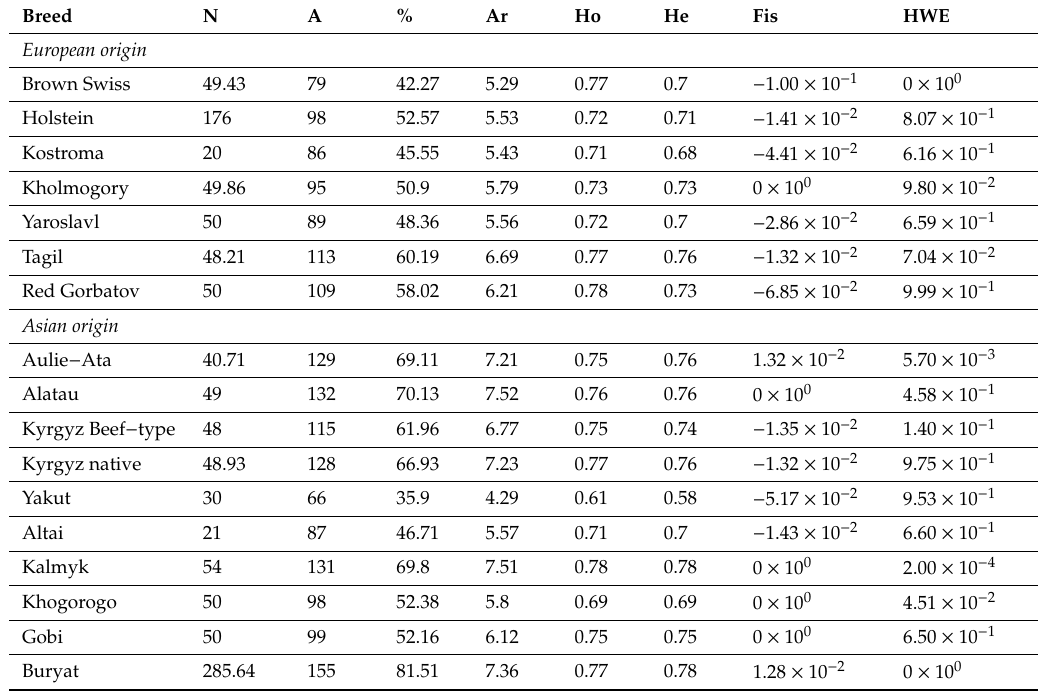
Table 2. Population parameters for the cattle samples